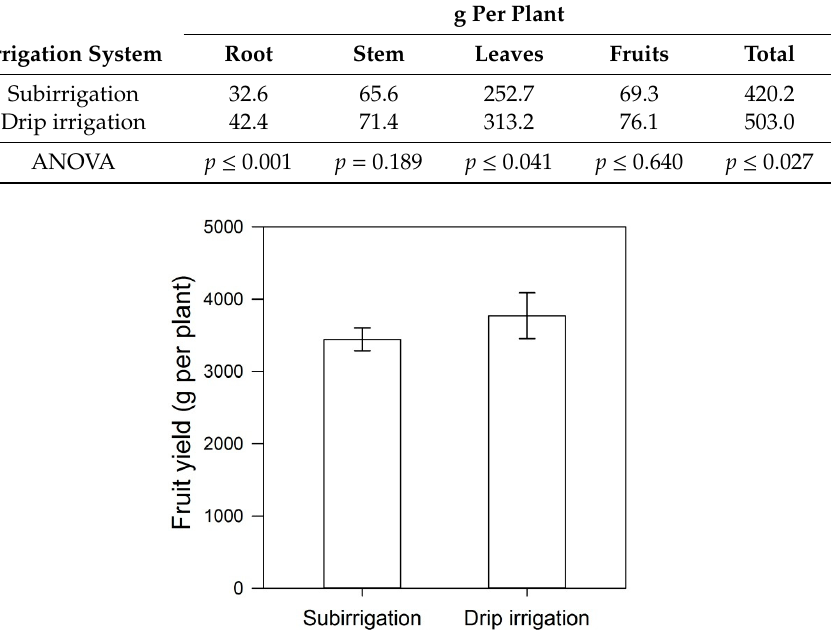
Dry Weight g Per Plant